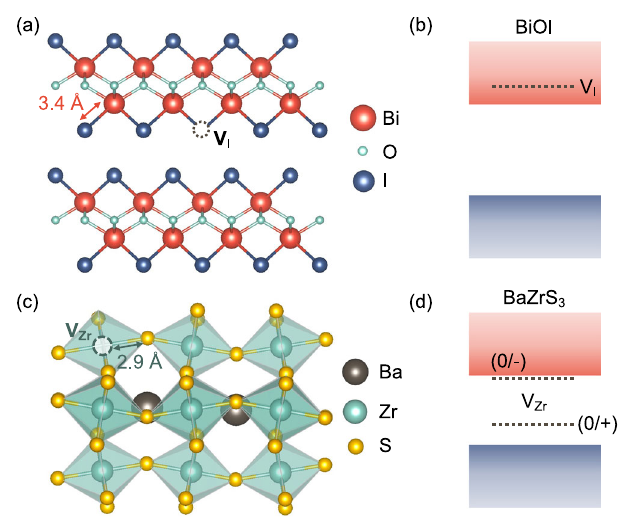
Fig. 2 | Wide-bandgap semiconductors with non-harmful traps. a Crystal structure and b band diagram of BiOI, showing the (0/+) transition level of iodide vacancies(V I ) 16 . c Crystalstructureand d banddiagramofBaZrS 3 ,showingthedeep donor (0/+) and shallow acceptor (0/ – ) transition levels of zirconium vacan- cies (V Zr ) 19